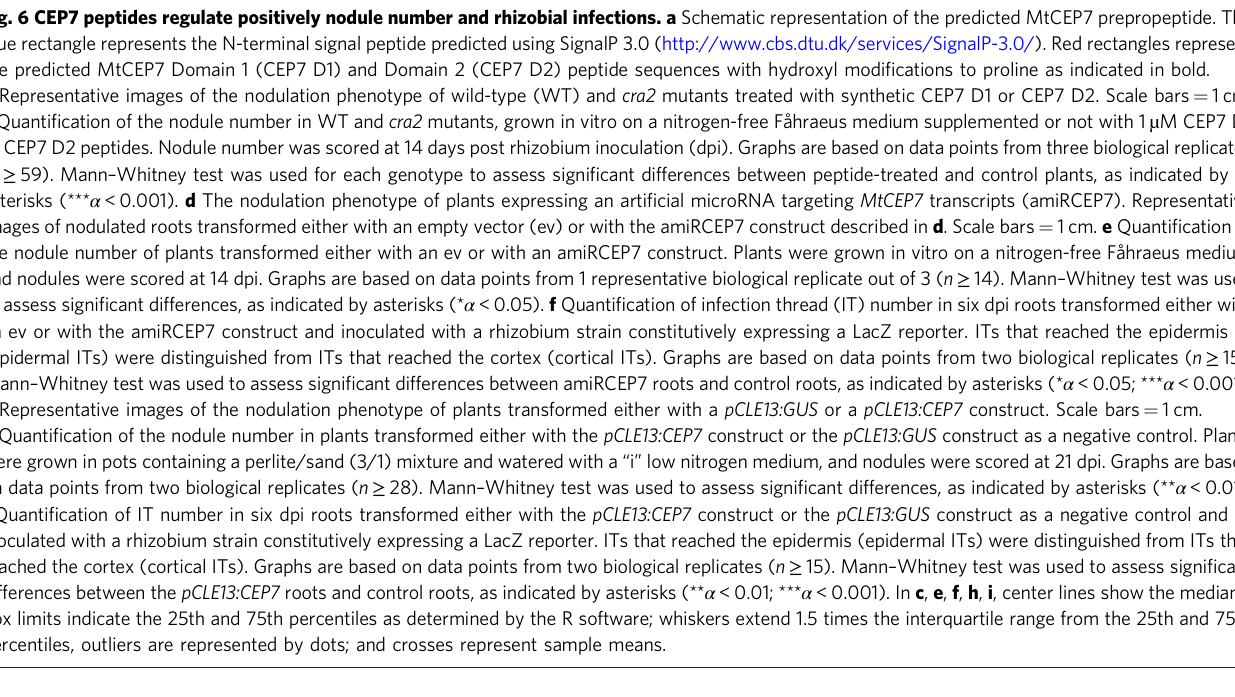
Fig. 6 CEP7 peptides regulate positively nodule number and rhizobial infections. a Schematic representation of the predicted MtCEP7 prepropeptide. The blue rectangle represents the N-terminal signal peptide predicted using SignalP 3.0 (http://www.cbs.dtu.dk/services/SignalP-3.0/). Red rectangles represent the predicted MtCEP7 Domain 1 (CEP7 D1) and Domain 2 (CEP7 D2) peptide sequences with hydroxyl modi fi cations to proline as indicated in bold. b Representative images of the nodulation phenotype of wild-type (WT) and cra2 mutants treated with synthetic CEP7 D1 or CEP7 D2. Scale bars = 1cm. c Quanti fi cation of the nodule number in WT and cra2 mutants, grown in vitro on a nitrogen-free Fåhraeus medium supplemented or not with 1 µ M CEP7 D1 or CEP7 D2 peptides. Nodule number was scored at 14 days post rhizobium inoculation (dpi). Graphs are based on data points from three biological